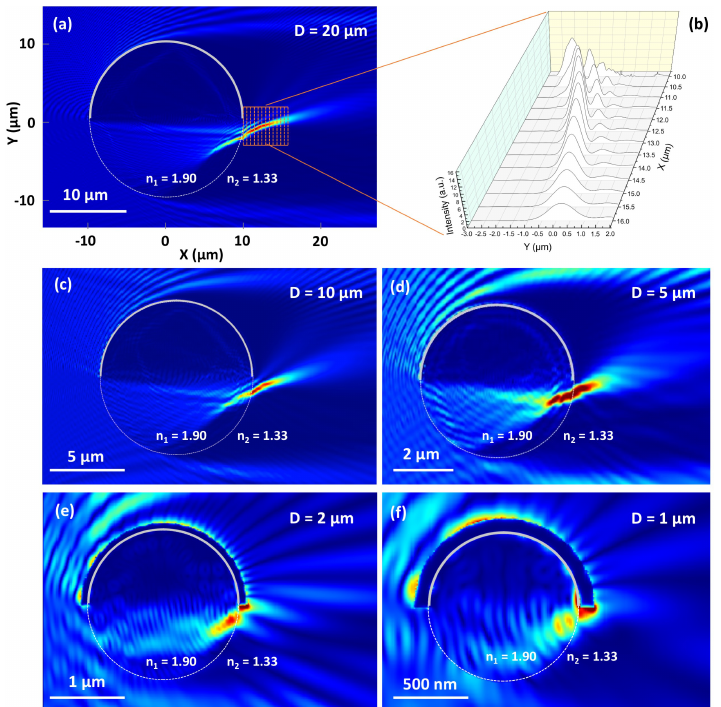
Figure 4. ( a ) Optical field of the 20 µ m-diameter patchy microcylinder and ( b ) the cross-sectional profiles of the corresponding PH. ( c – f ) Optical fields of the patchy microcylinders with a diameter of ( c ) 10 µ m, ( d ) 5 µ m, ( e ) 2 µ m and ( f ) 1 µ